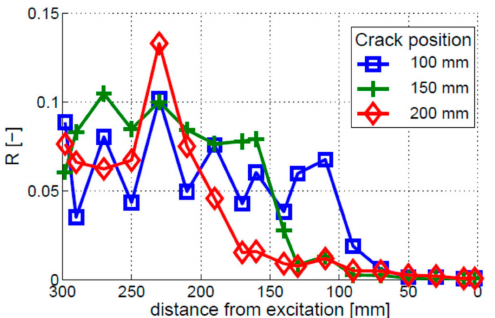
Figure 10. Crack localization effect for three different crack positions. The bi-linear crack model was used. The simplified piezo model was applied for the ultrasonic HF